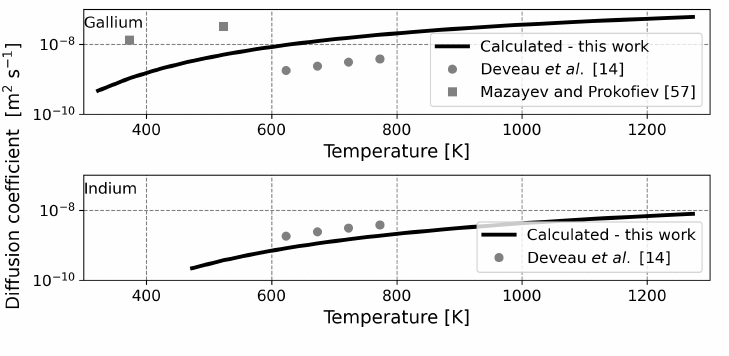
Figure 4. Calculated and experimentally obtained diffusion coefficients for gallium ( top ) and indium ( bottom ). The X -axis is shared. Dots represent experiments and lines represent calculations. Data from Mazayev and Prokofiev and Deveau et al.